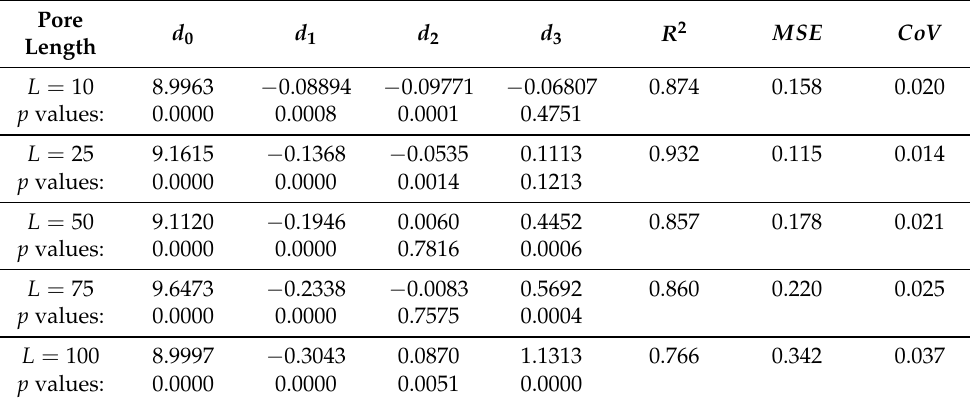
Figure 8. A schematic view of CLB translocations along narrow pores: conical vs. cylindrical. Table 2. Estimated regression models (7) for selected pore lengths L